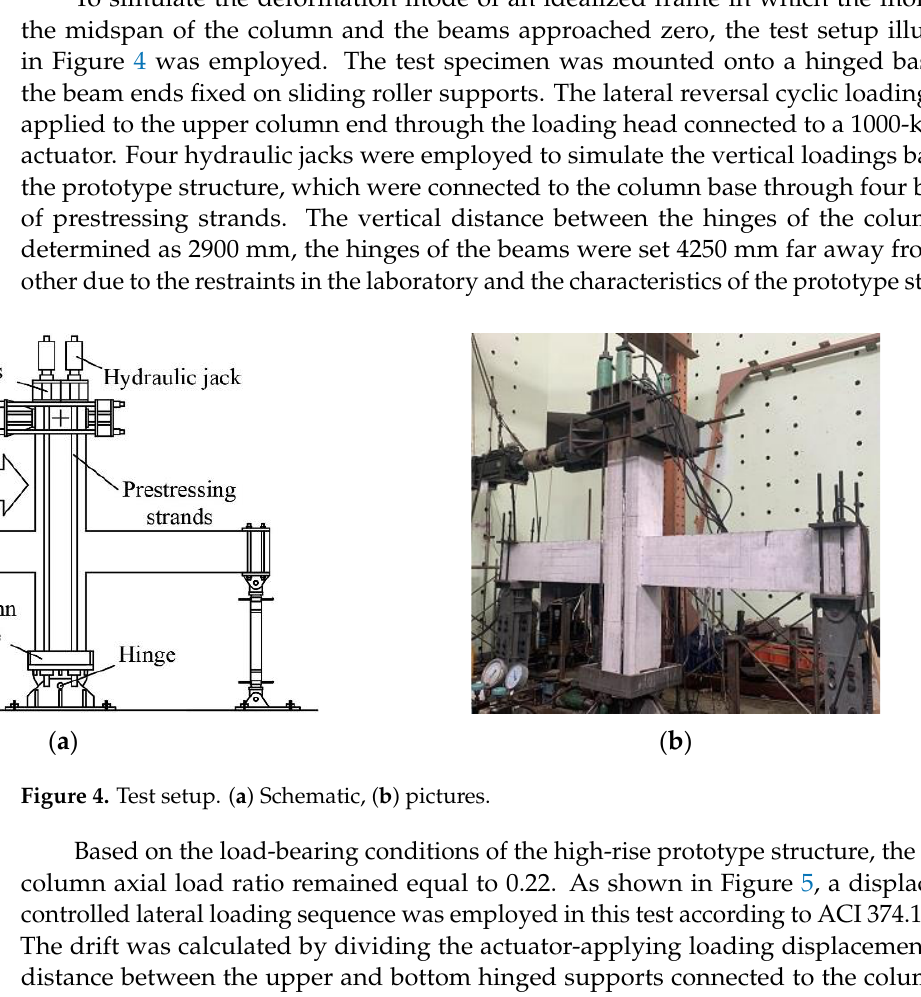
( c ) Figure 6. Failure modes of specimens. ( a ) S1 , ( b ) PU1, ( c ) PU2.